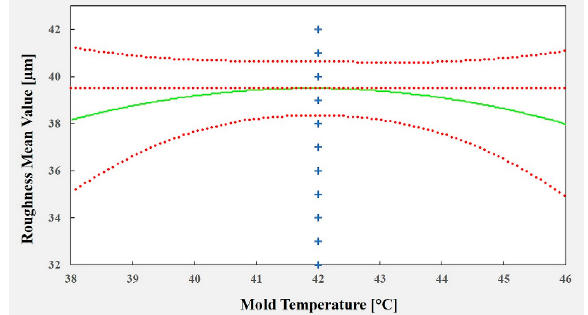
Figure 23. Effect of each predictor on the surface roughness model.